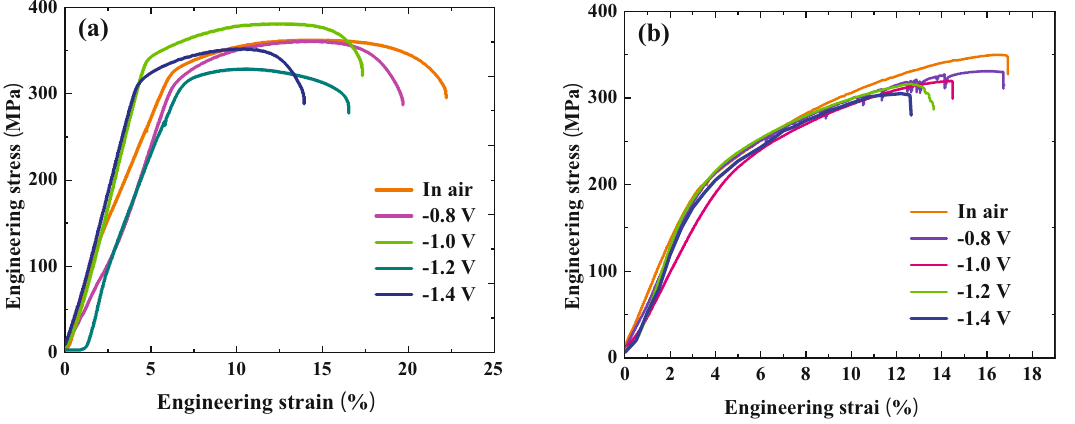
Figure 3: SSRT tensile test results: ( a ) engineering stress – strain curve of the base metal and ( b ) engineering stress – strain curve of 7N01 - T4 welded